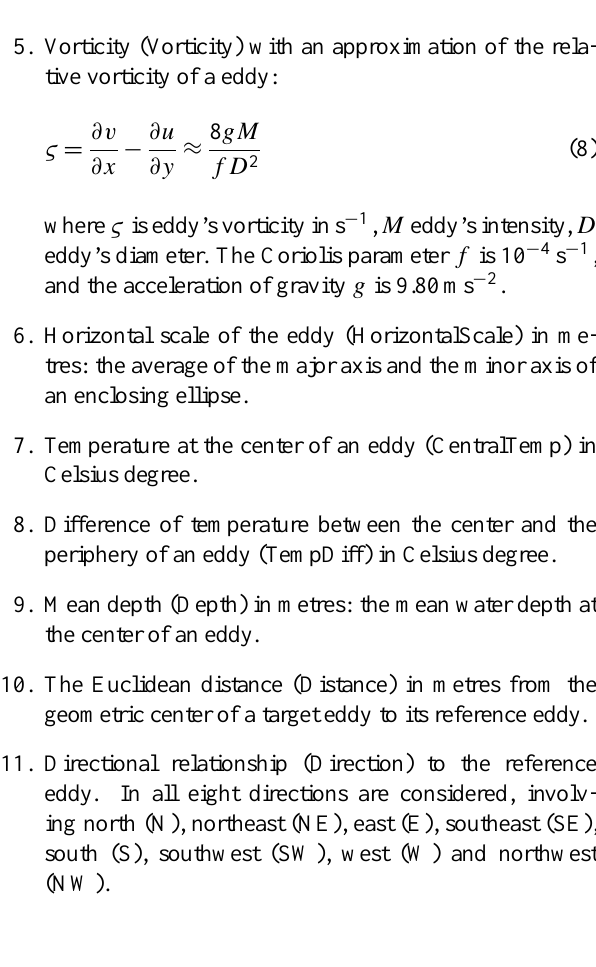
Fig. 4. Sketch map of a mesoscale eddy in the SCS (outlined by bright green